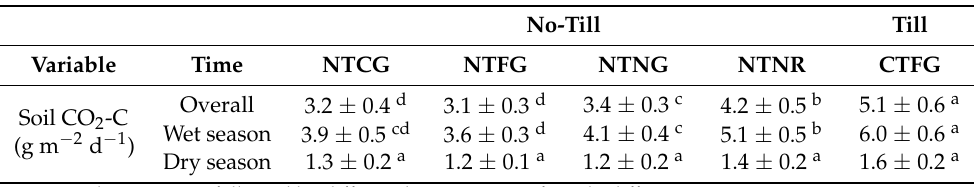
Table 2. Mean ± SE (standard error) of soil CO 2 -C effluxes (CO 2 -C) under conventional tillage with free grazing (CTFG), no-tillage with free grazing (NTFG), no-tillage with no grazing (NTNG), no-tillage without crop residue mulching (NTNR) and no-tillage with controlled grazing (NTCG). N = 120, 90, 30, for overall average, wet and dry period,